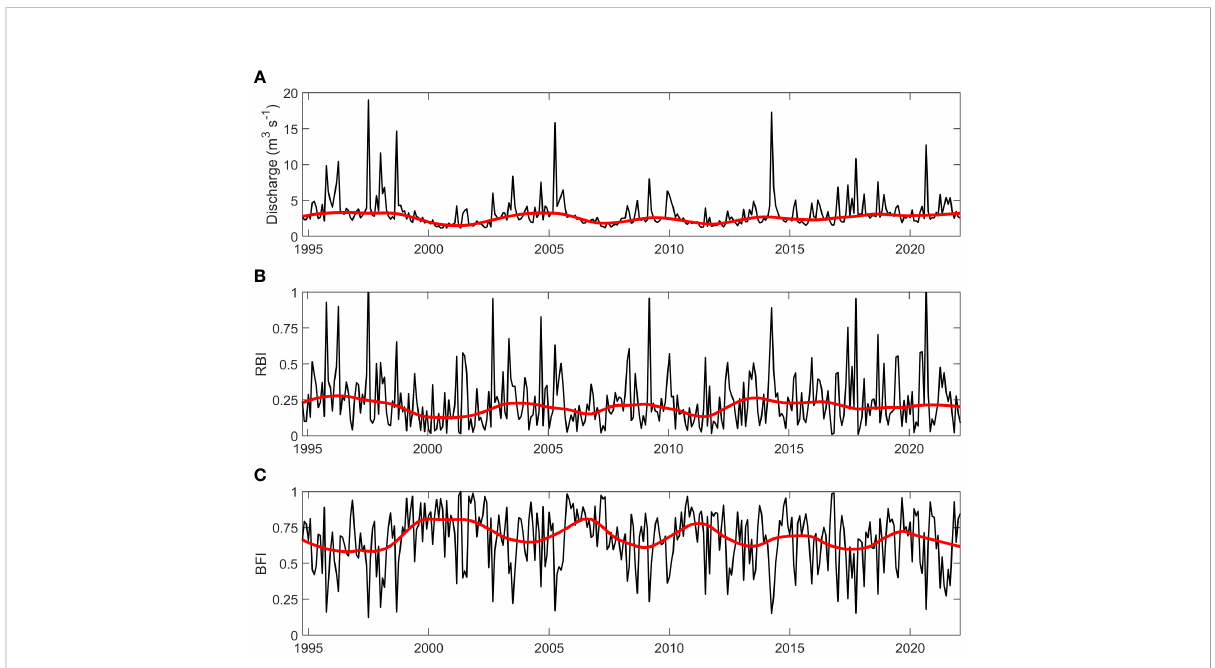
FIGURE 4 Hydrological variable values (black) and fi tted rloess curves (red) at the gauge for (A) monthly mean discharge (m 3 s -1 ), (B) monthly Richards- Baker Index (RBI, unitless) and (C) monthly Base fl ow Index (BFI,